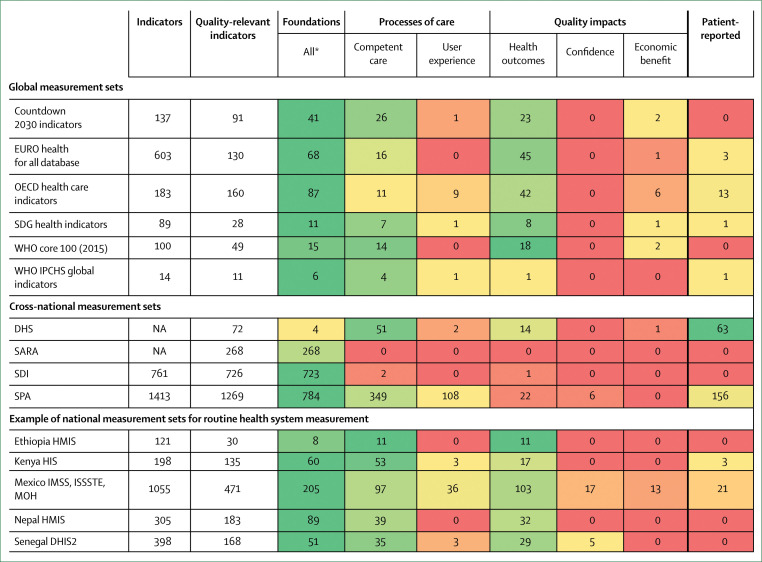
Representation of quality subdomains in global, crossnational, and national measurement setsWe mapped indicators against domains of the high-quality health systems framework (figure 1), identifying the single domain most relevant for each indicator. We additionally classified indicators as patient-reported if the data were collected with individual self-reports. Full methods are detailed in appendix 1. Cells are coloured by greatest number of indicators per row (source), with red indicating 0, orange and yellow the midrange, and green the maximum number observed for that measurement set. DHIS2=District Health Information System 2. DHS=Demographic and Health Surveys. HIS=Health Information System. HMIS=Health Management Information System. IMSS=Instituto Mexicano del Seguro Social. IPCHS=Integrated People-Centred Health System. ISSSTE=Instituto de Seguridad y Servicios Sociales de los Trabajadores del Estado. OECD=Organisation for Economic Co-operation and Development. SARA=Service Availability and Readiness Assessment. SDG=Sustainable Development Goals. SDI=Service Delivery Indicator Survey—health. SPA=Service Provision Assessment. * Population, governance, platforms, workforce, and tools.